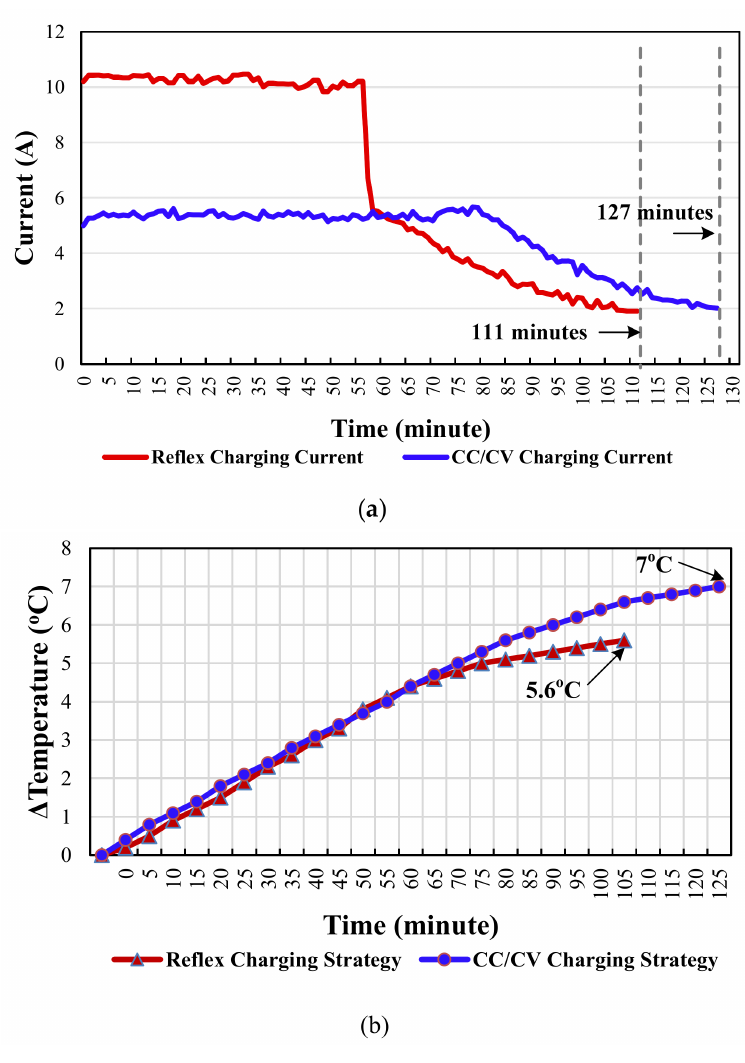
Figure 12. The comparison between the proposed RC-BDC and the conventional BDC with the CC/CV charging profile: ( a ) the battery charging current and ( b ) the increased battery temperature.